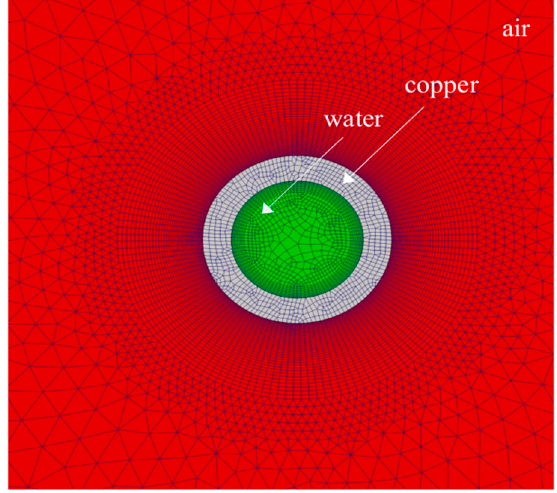
Figure 4. Unstructured multi-region mesh for the external pipe problem.